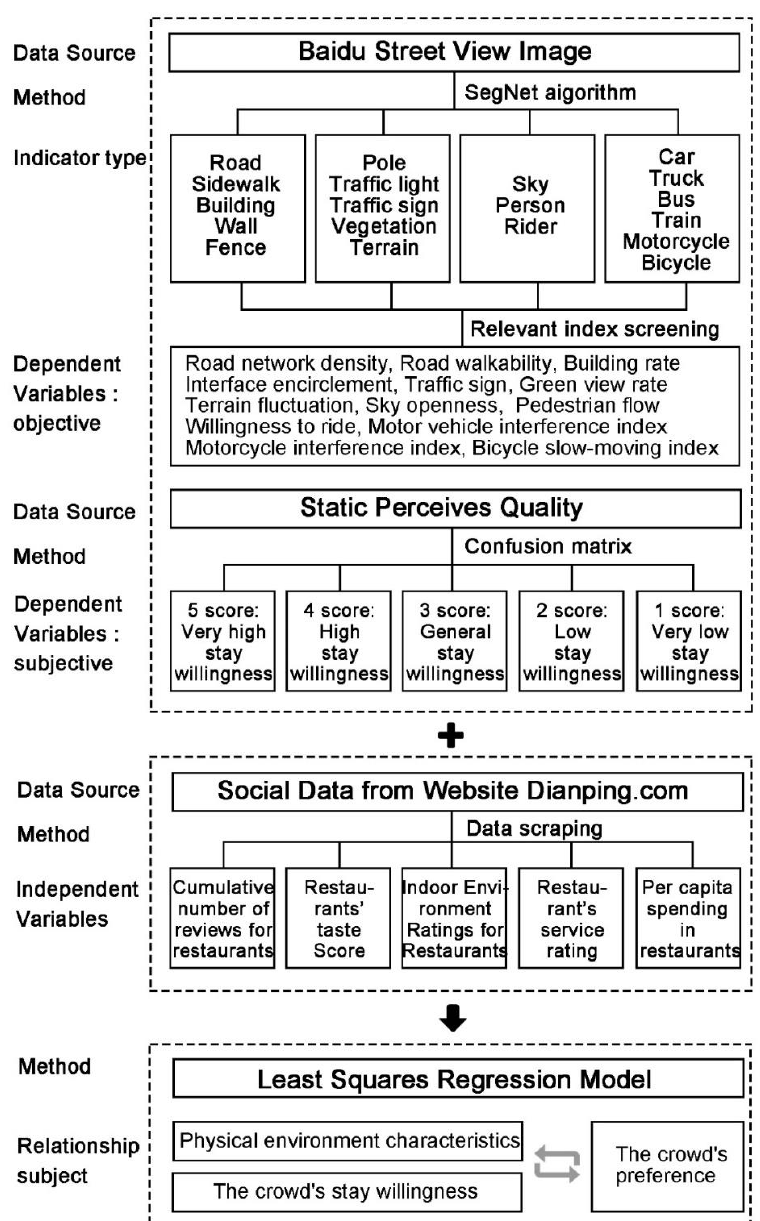
Figure 3. Indicator system and analytical framework.